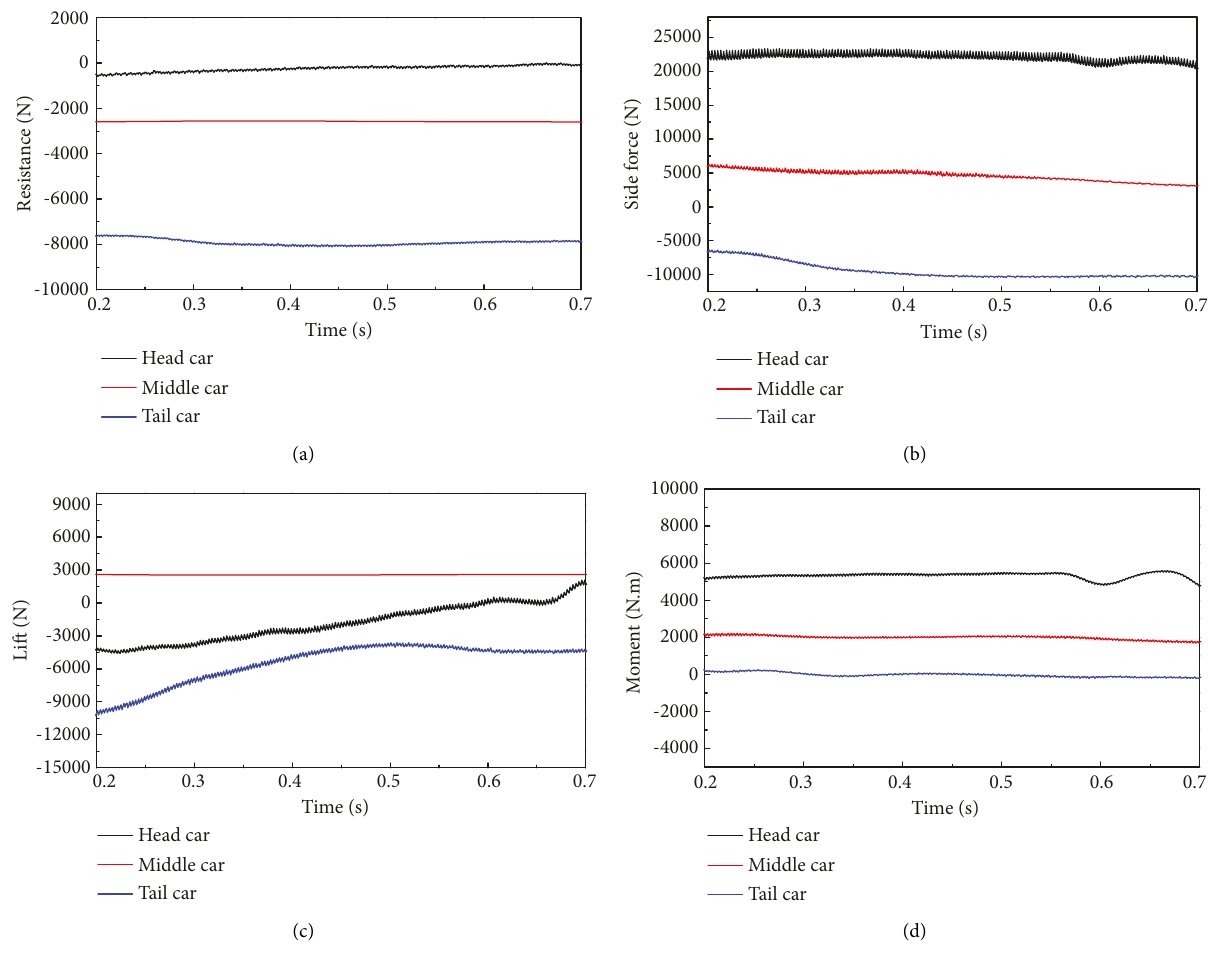
Figure 10: Aerodynamic force curves of each car. (a) Resistance. (b) Side force. (c) Lift. (d) Moment. Table 3: Maximum dynamic responses of